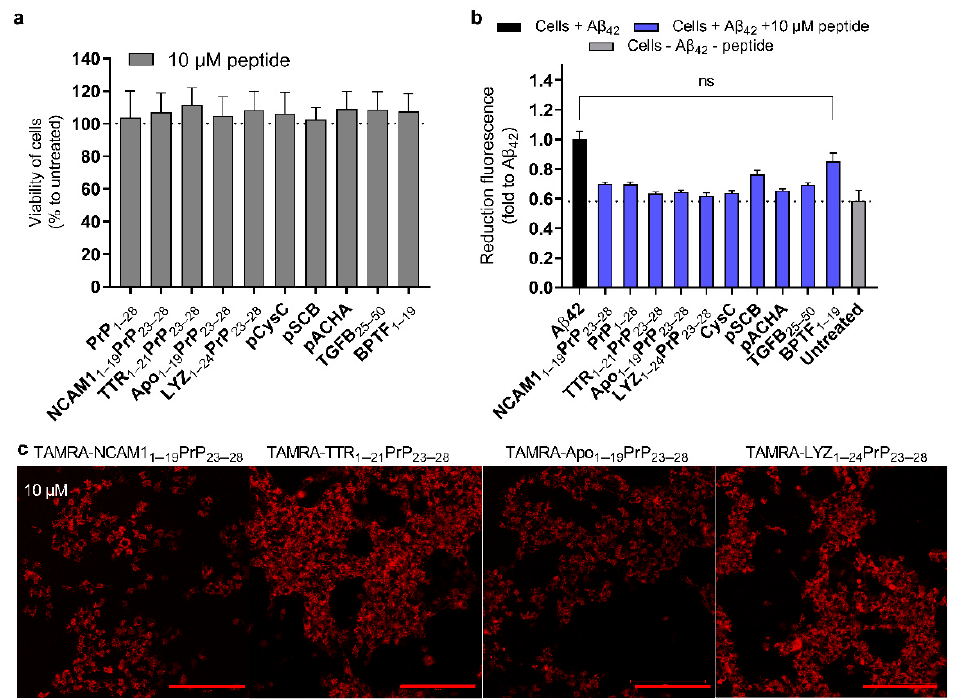
Figure 4. Peptides are not toxic to cells and can reduce A β 42 toxicity to the cells. ( a ) Cell viability after addition of the peptides was assessed using MTS assay 24 h post-addition of peptides on U87 cells in serum containing media. The final concentration of the peptides on cells was 10 µ M. Peptides were assessed in the absence of amyloid peptide. ( b ) Reduction in amyloid toxicity on U87 cells after addition of peptides, using ToxGreen assay. Results are shown as fold change to fluorescence detected from cells treated with A β 42. Unpaired t -test with Welch correction. ns = p > 0.05, all other groups when compared to the A β 42 group were revealed as statistically significant (not marked). ( c ) Internalization of labelled peptides 2 h post-addition to U87 cells. Confocal images were captured with 20× objective, red bar 200 µm.